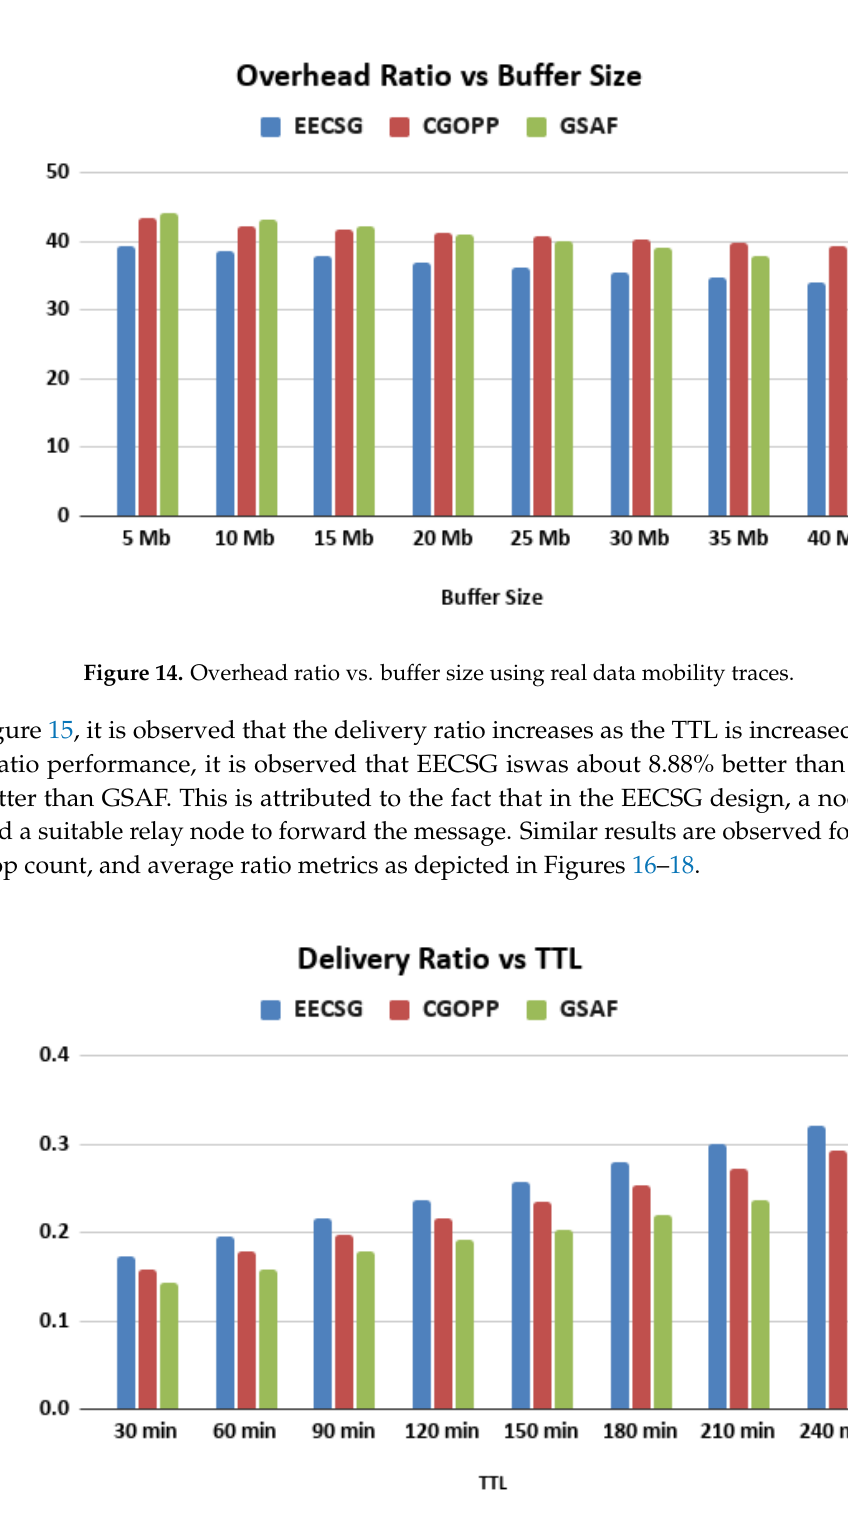
Figure 15. Delivery ratio vs. TTL using real data mobility